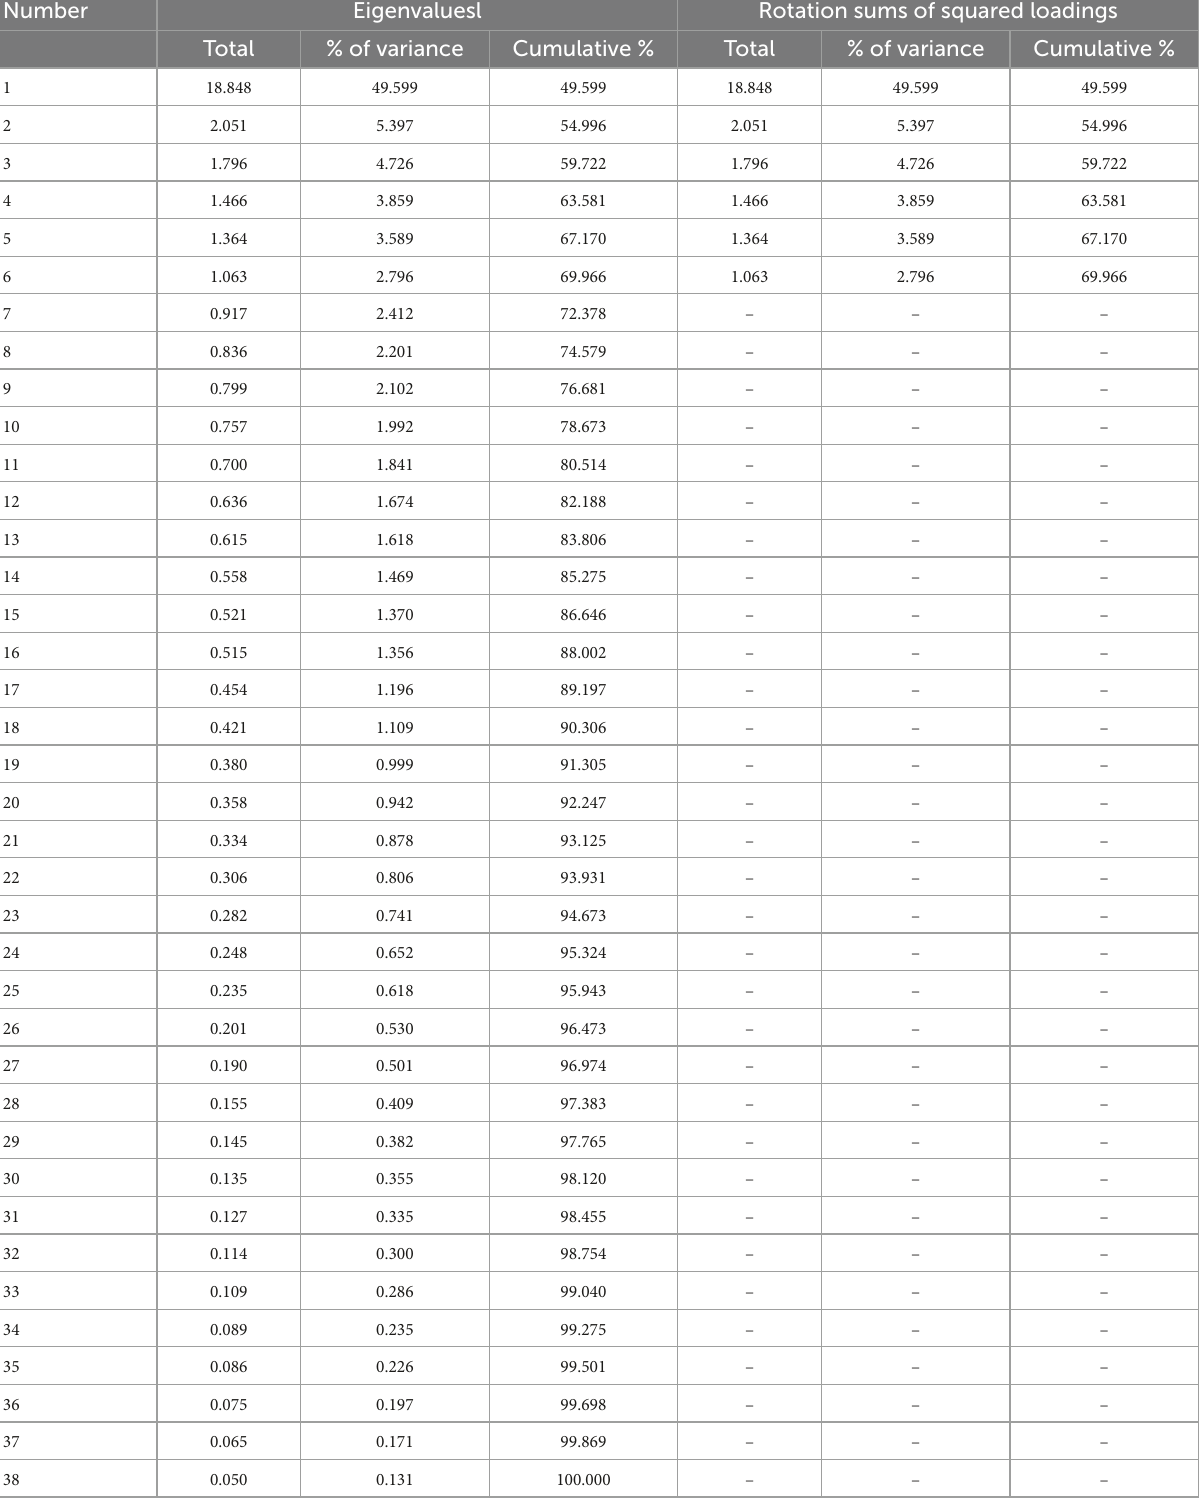
TABLE 6 Total variance